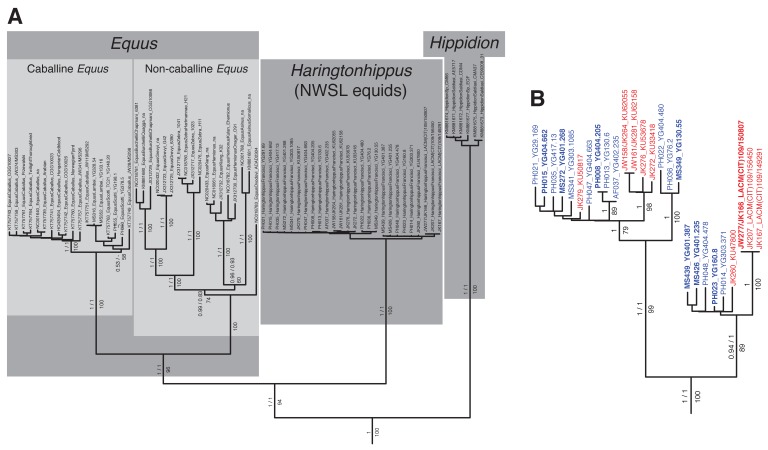
An example maximum likelihood (ML) phylogeny of equid mitochondrial genomes.This topology resulted from the analysis of mtDNA data set 3 (see Appendix 1) with all partitions and Hippidion included, and dog and ceratomorphs as outgroup (not shown). Numbers above branches are Bayesian posterior probability support values from equivalent MrBayes and BEAST analyses, with those below indicating ML bootstrap values calculated in RAxML, and are shown for major nodes. (A) Full phylogeny of the analyzed equid sequences. (B) The Haringtonhippus (NWSL equid) clade, with tips color coded by geographic origin: east Beringia, blue; contiguous USA, red (following Figure 3). Tips in bold were included in the BEAST analysis (see also Supplementary file 1).